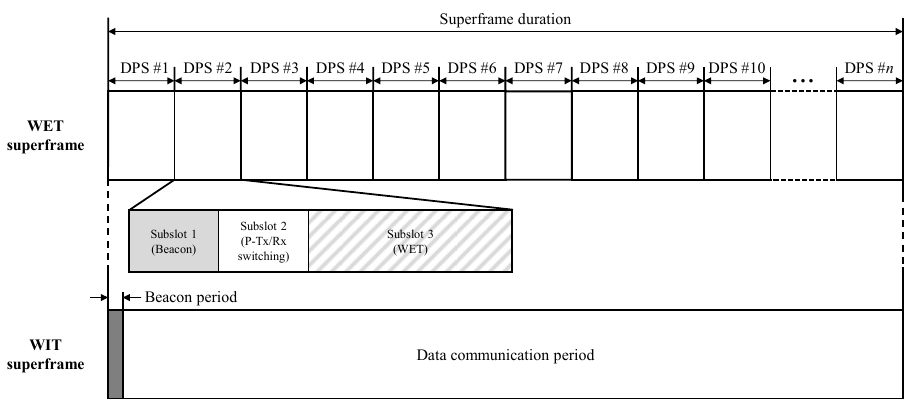
Figure 2. WET and WIT superframe structure.